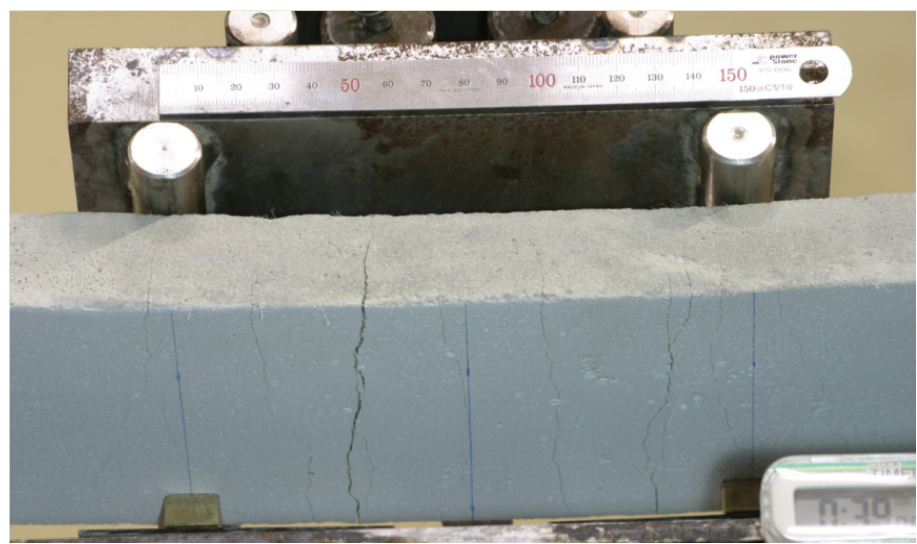
Figure 6. Typical crack patterns of the HPFRCC